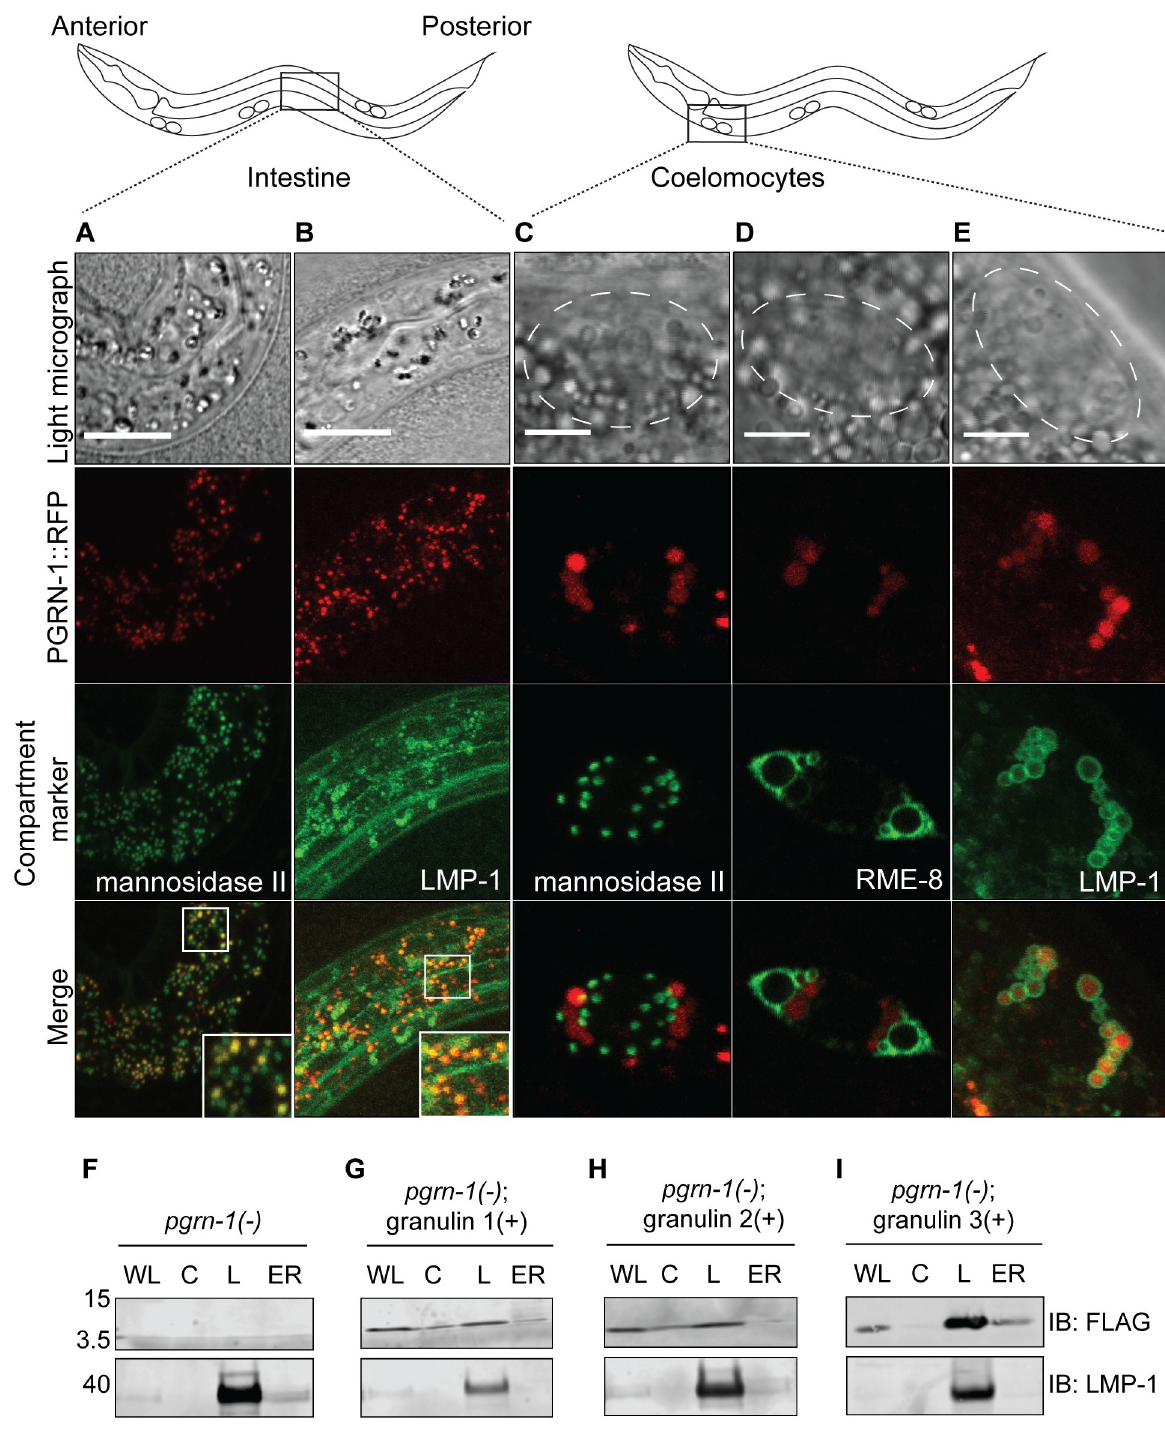
Fig 2. C . elegans progranulin and granulins localize to the endolysosomal compartment. A translational PGRN-1::RFP reporter (red) co- localizes with ( A ) Golgi (mannosidase II::GFP) and ( B ) lysosomes (LMP-1::GFP) in the intestine of L1 stage larvae (anterior to the left). In scavenging coelomocytes, PGRN-1::RFP does not co-localize with ( C ) Golgi (mannosidase II::GFP), but does co-localize with ( D ) early, late and recycling endosomes (RME-8::GFP) and ( E ) lysosomes (LMP-1::GFP) (n = 8 animals per GFP marker). Dashed white lines mark the outline of each coelomocyte cell and white boxes show zoomed insets in Fig 2A-B, scale bar = 5 μ m. Shown are representative images from confocal microscopy z- stack sections taken at 0.7 μ m. ( F-I ) Subcellular fractionation of pgrn-1(-) animals ( F ), and pgrn-1(-) animals with expression of ( G ) granulin 1, ( H ) granulin 2, and ( I ) granulin 3. Whole lysate (WL), cytosol (C), lysosome (L) and endoplasmic reticulum (ER) fractions (10 μ g total protein) were immunoblotted with anti-FLAG and anti-LMP-1